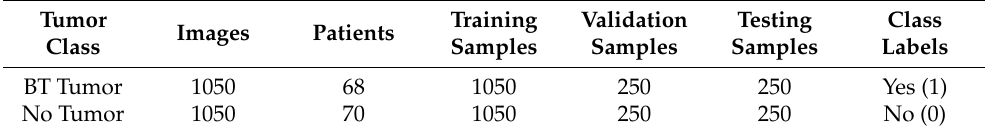
Table 1. The brain dataset